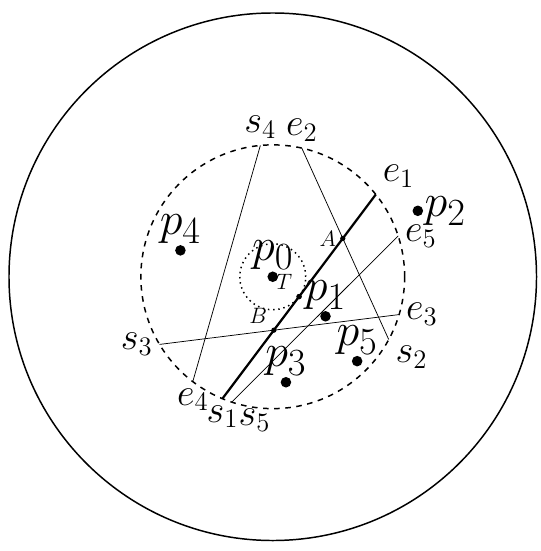
Figure 3. The determination of the initial